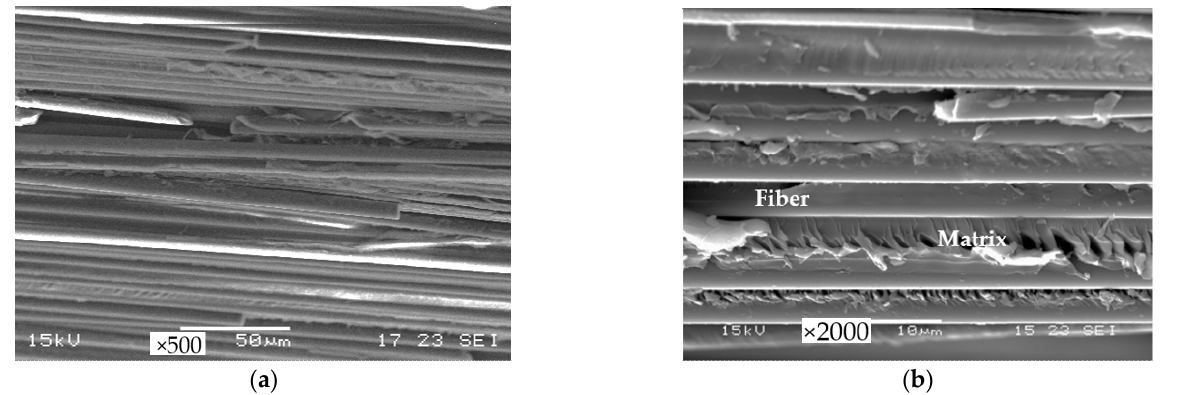
Figure 7. Microscopic fracture modes obtained in compression; ( a ) general view; ( b ) serrated type fracture in the matrix epoxy resin.